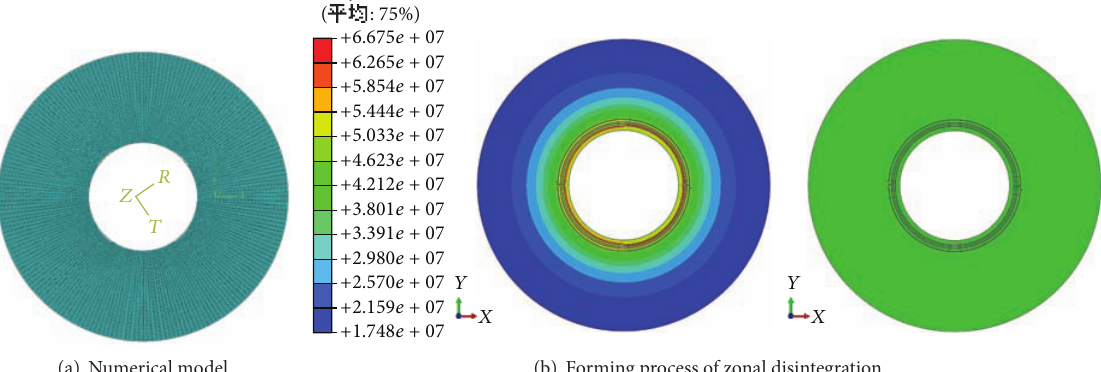
Figure 10: Zonal disintegration of circular model obtained with